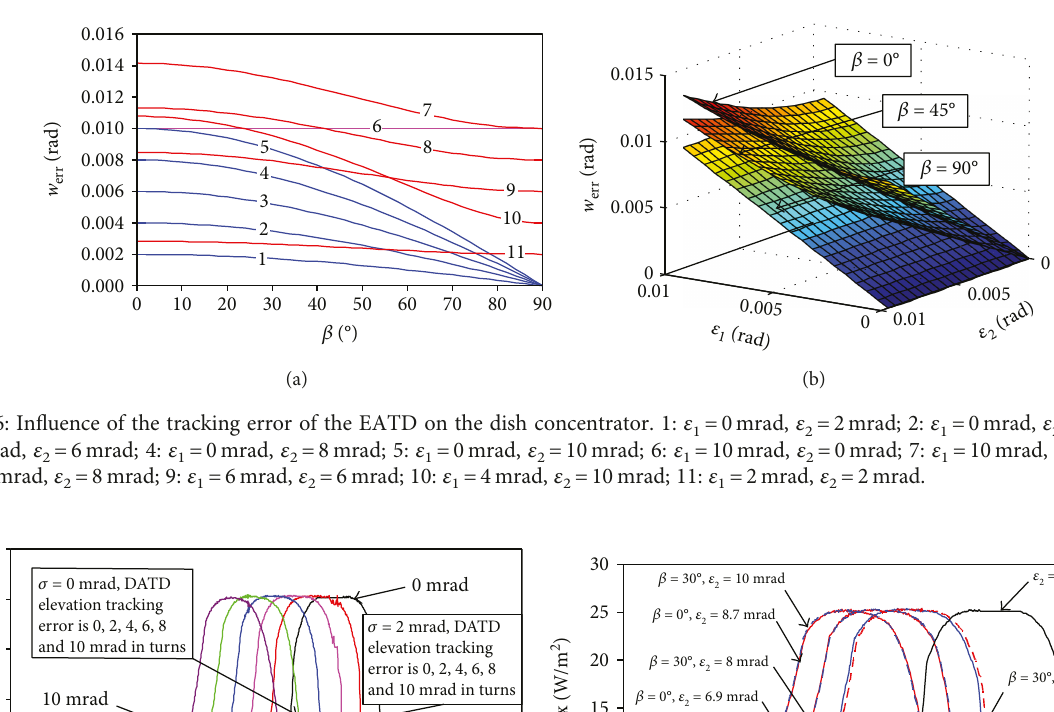
=6 mrad; 4: ε 2 =8 mrad; 9: ε 2